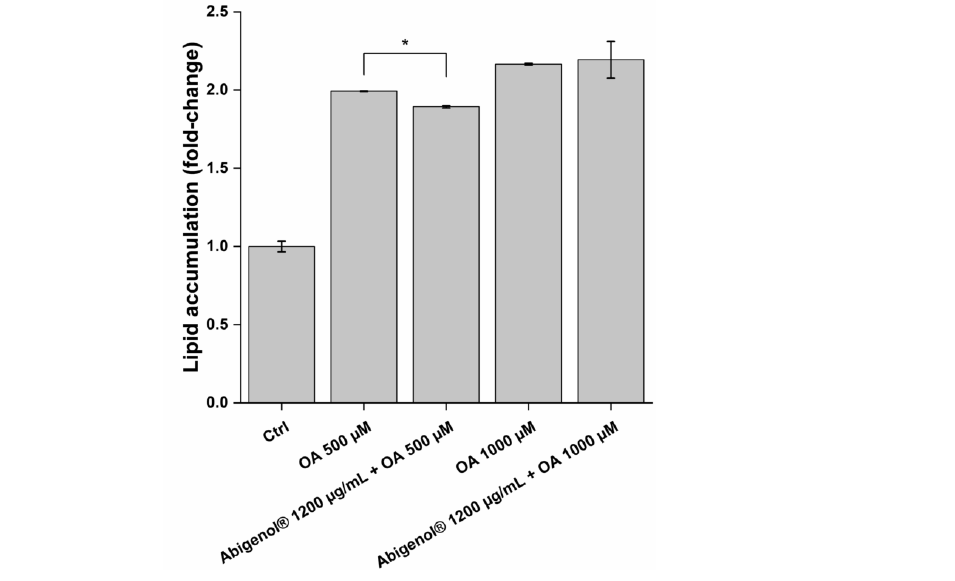
Figure 9. Intracellular lipid accumulation in HepG2 cells after a protective treatment with Abigenol ® /AlbiPhenol ® (24 h with the formulation, followed by 24 h with the formulation + oleic acid). Intracellular lipids were normalized on DAPI. AU: arbitrary units; Ctrl: control (untreated cells); OA: oleic acid. * p < 0.05. (n = 3).